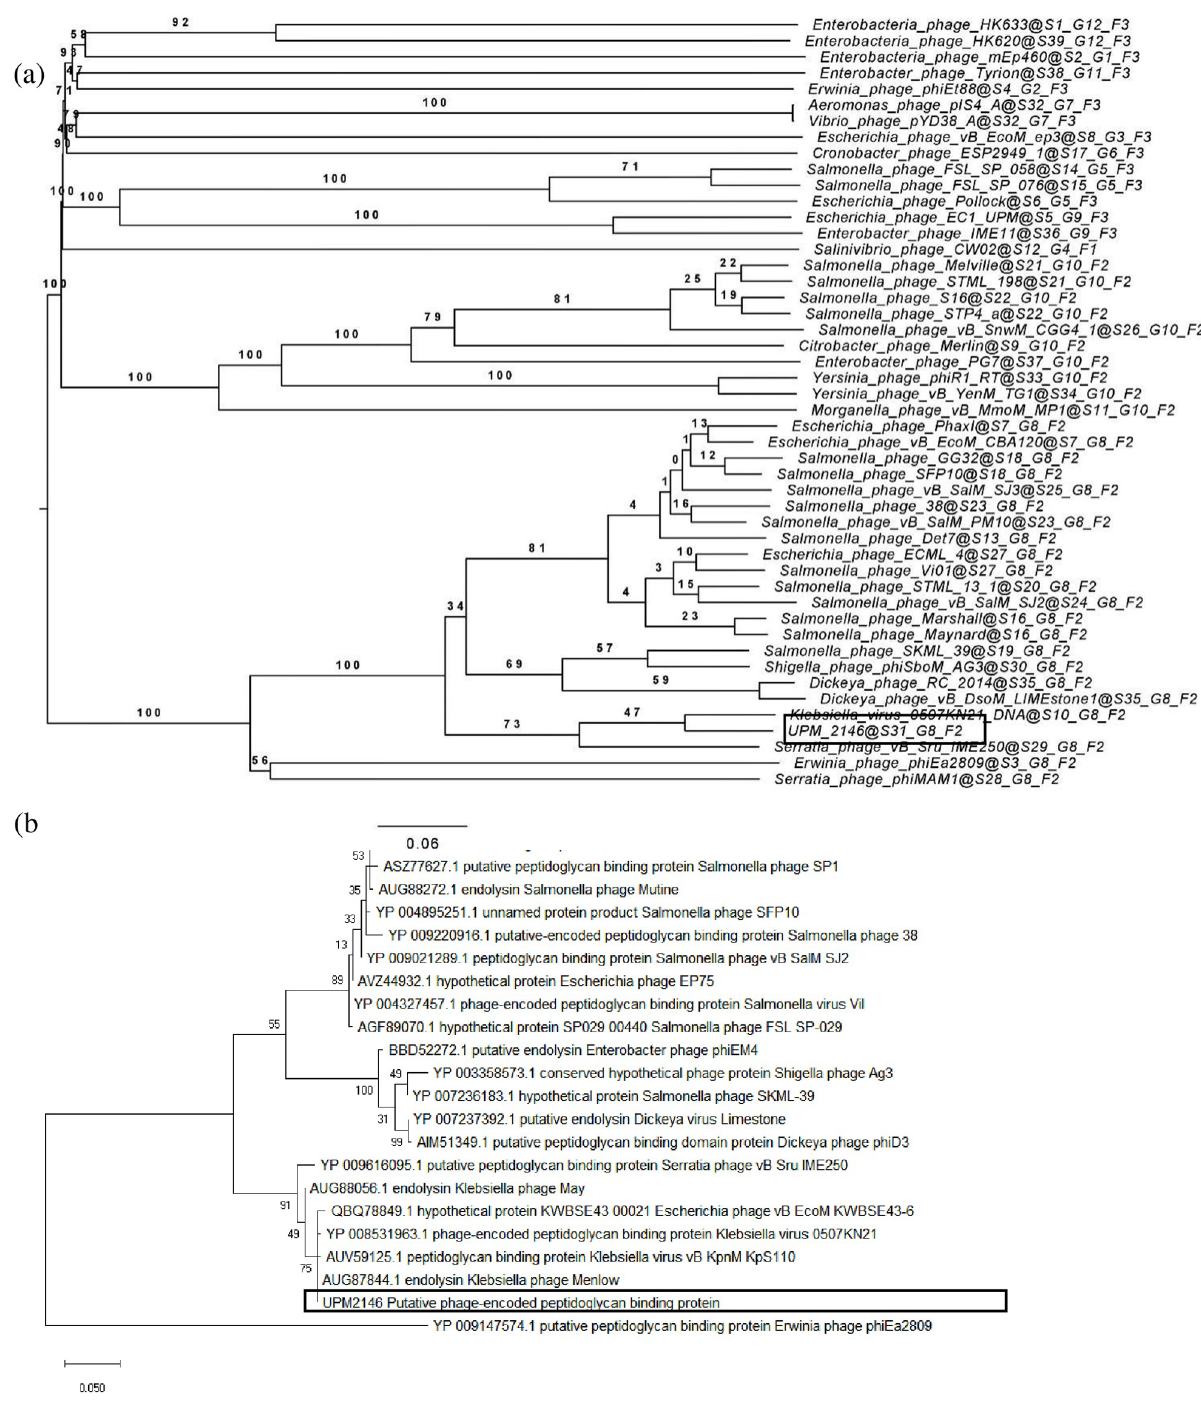
Fig 8. a. Phylogenic tree of UPM2146 show that the phylogenomic GBDP trees inferred using D6 formula and yielding average support of 58%, The numbers above branches are GBDP pseudo-bootstrap support values from 100 replications. The branch lengths of the resulting VICTOR tree are scaled in terms of D6 formula used. b. The evolution of UPM2146 of putative phage-encoded peptidoglycan binding protein had been drawn using phylogenic tree analysis using 1000 bootstrap, using the maximum likelihood (ML) method based on the Jones-Taylor-Thornton (JTT) model, the tree with the highest log likelihood (-1805.44) is shown. The percentage of trees in which the associated taxa clustered together is shown next to the branches. Initial tree(s) for the heuristic search were obtained by applying the Neighbor-Joining method to a matrix of pairwise distances estimated using a JTT model. The tree is drawn to scale, with branch lengths measured in the number of substitutions per site. This analysis involved 22 amino acid sequences. All positions containing gaps and missing data were eliminated (complete deletion option). There were a total of 261 positions in the final dataset. Evolutionary analyses were conducted in MEGA X